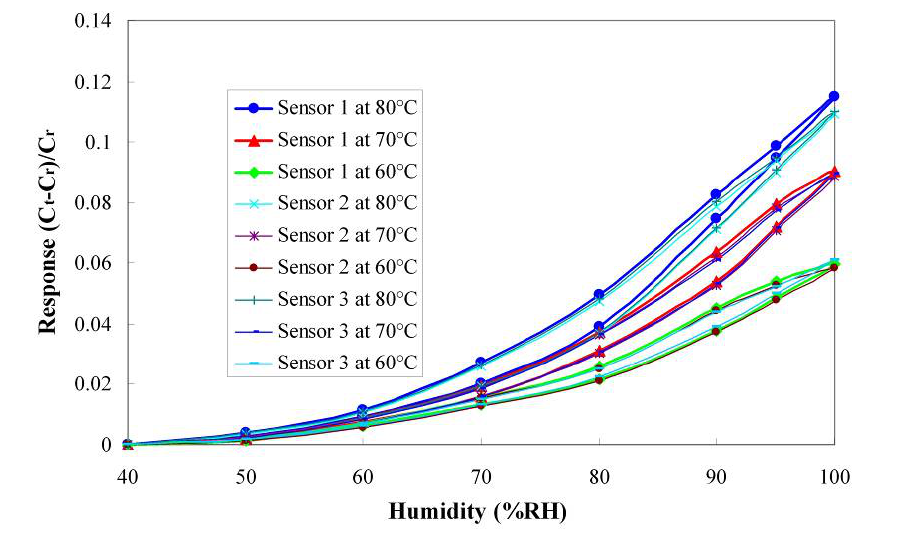
Figure 8. Calibration curves of micro humidity sensors at 60 °C, 70 °C and 80